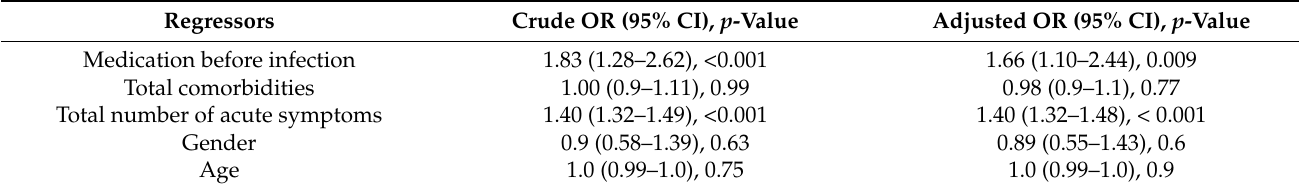
Table 3. Regressors predicting persistent symptoms after SARS-CoV-2 infection.